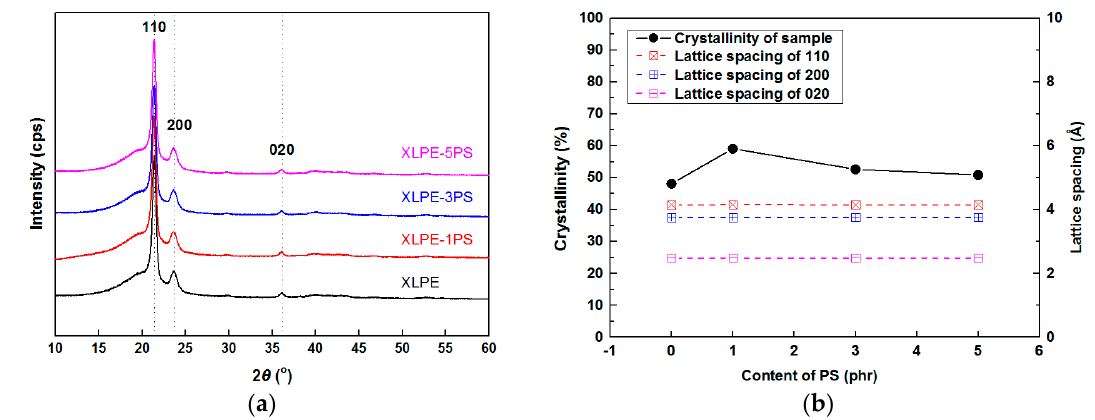
Figure 7. The XRD results of samples. ( a ) XRD spectra; ( b ) crystallinity and lattice spacing calculated from XRD data.